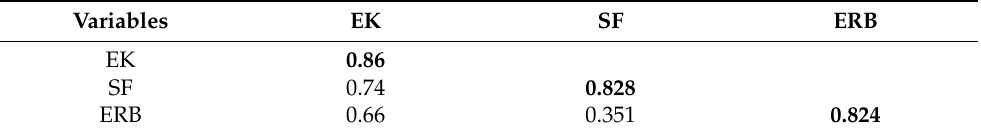
Table 3. Discriminant validity of